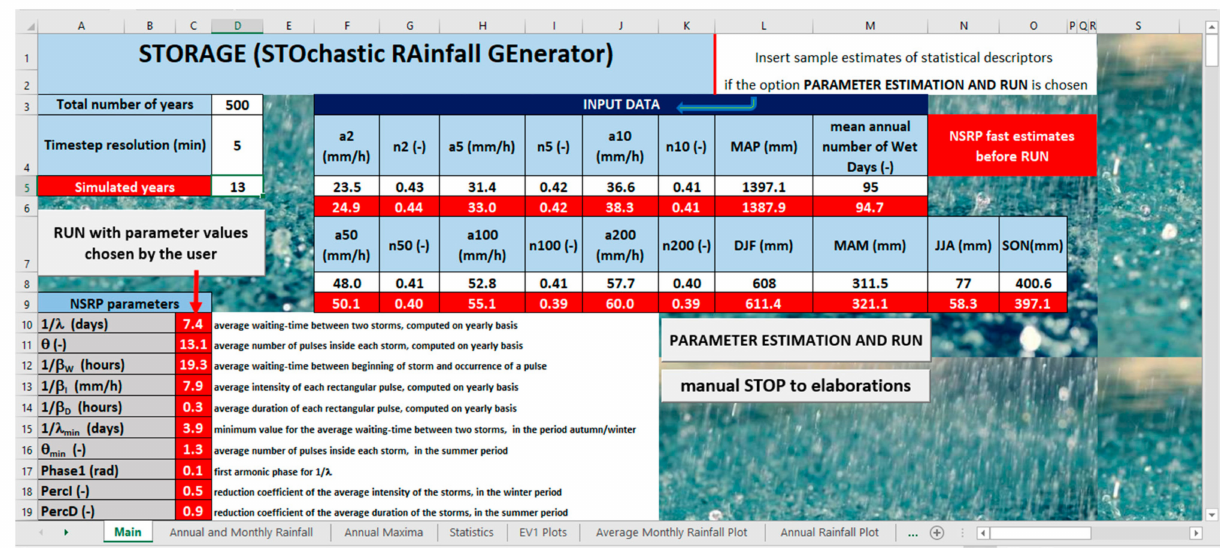
Figure 9. During the run, the user can control the progress of generation by checking the number of simulated years in the cell D5 in the Main